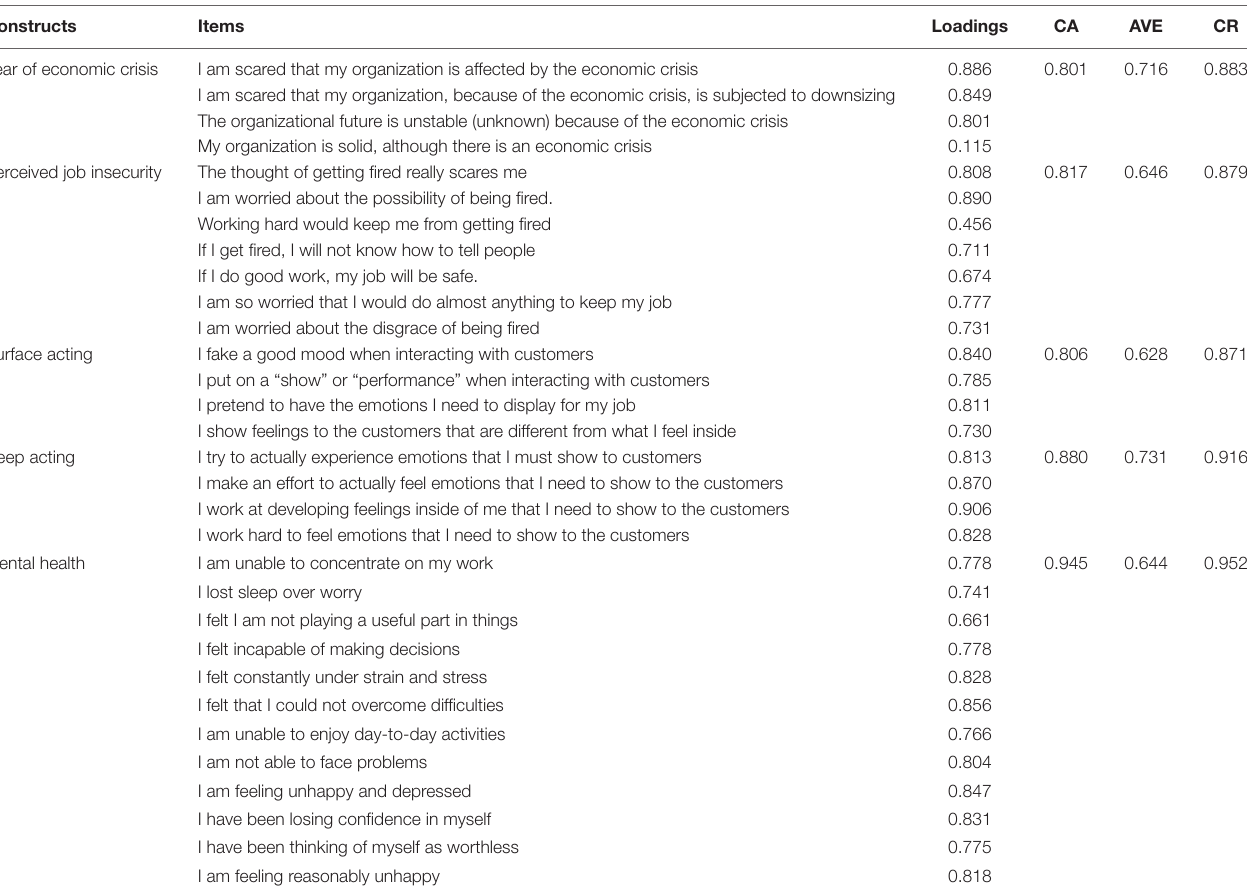
TABLE 2 | Validity and reliability for constructs.